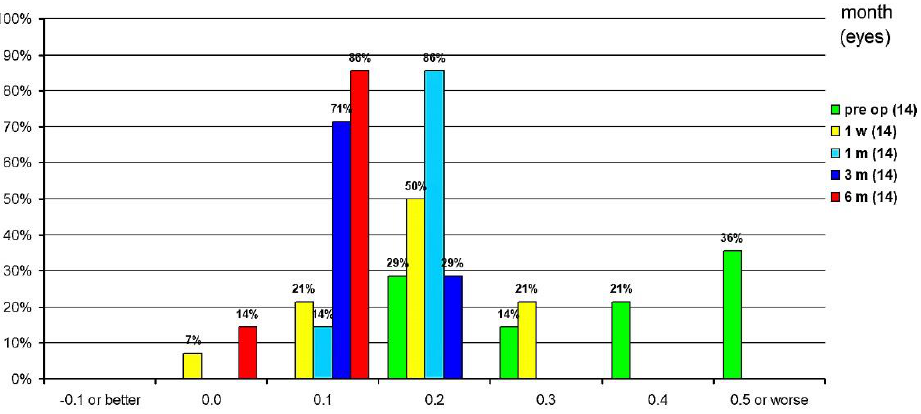
Figure 9. Distribution of uncorrected distance visual